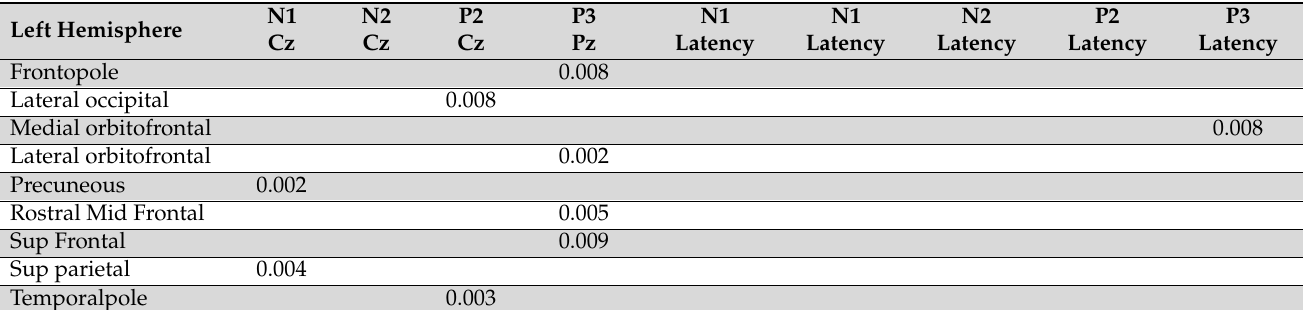
Table 2. Bivariate correlations between amplitude and latency of ERP components and FreeSurfer regions in the left hemisphere (N = 217).